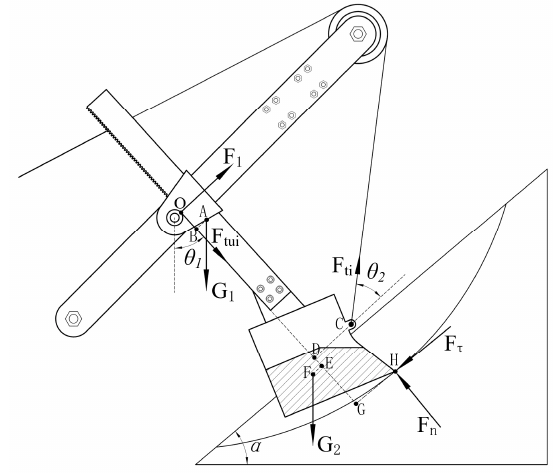
Figure 4. Force analysis of the excavation process.